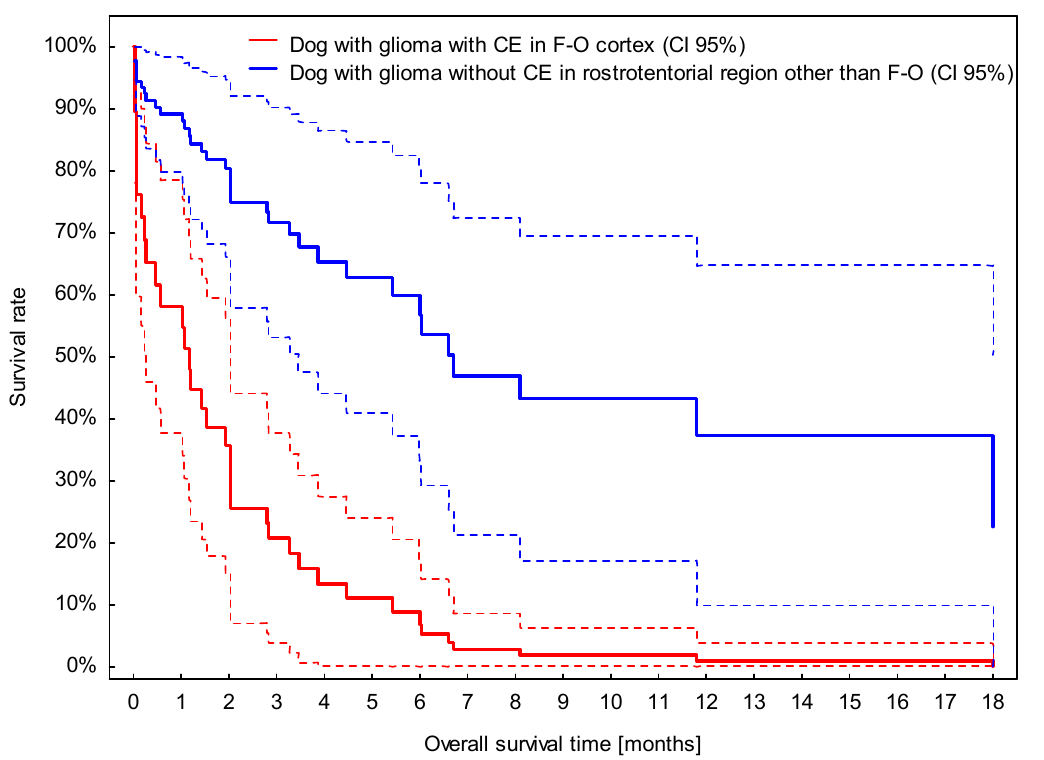
Figure 6. Survival curves for dogs with presumed glioma located in the fronto-olfactory cortex (F-O) with contrast enhancement (CE) and located in other rostrotentorial regions without CE. Broken lines stand for 95% confidence intervals (CI 95%) for estimated survival curves.